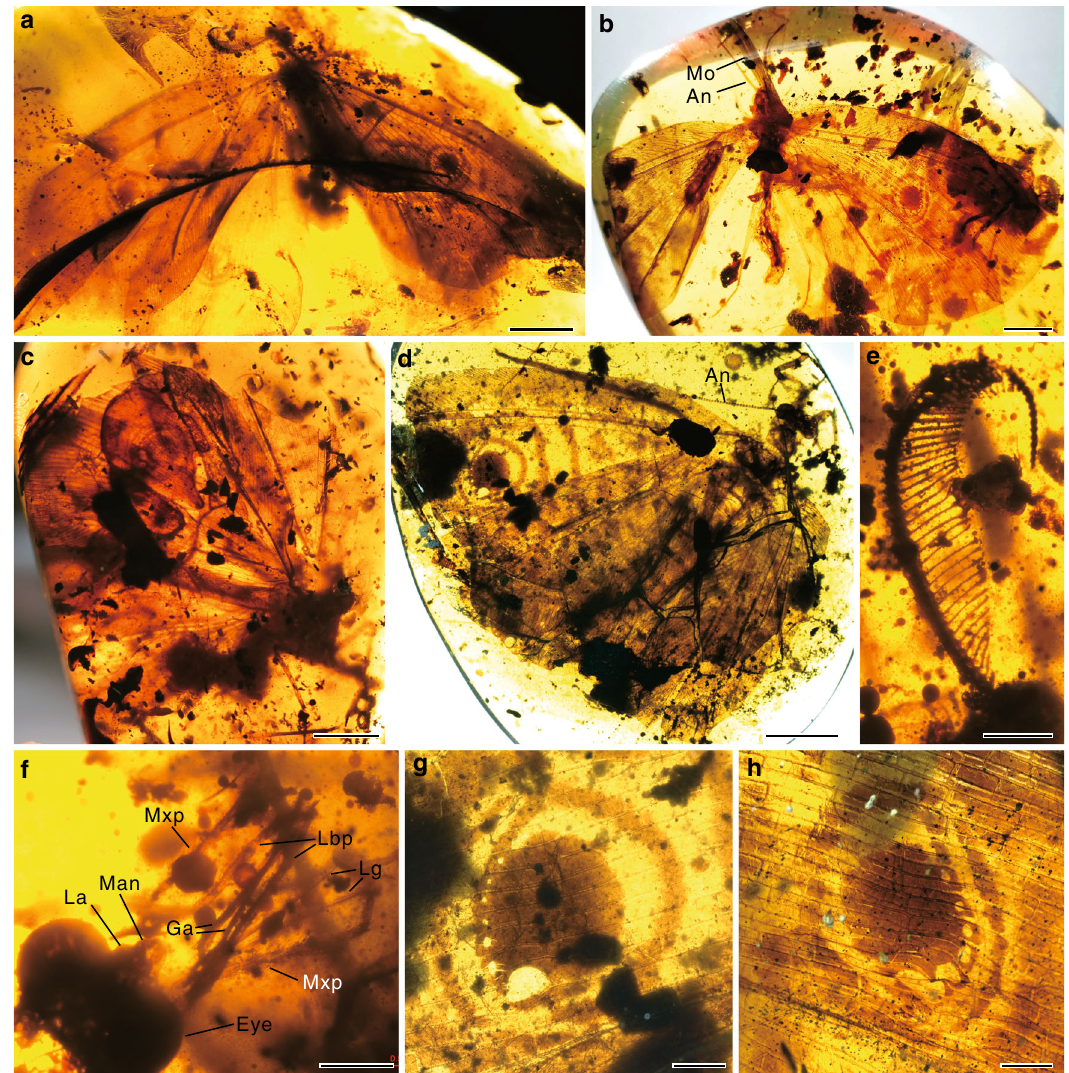
Fig. 1 Burmogramma liui from late Cretaceous Burmese amber. a , e , f Holotype NIGP164471, male, habitus ( a ), antenna ( e ) and mouthparts ( f ). b , g Paratype NIGP164472, female, habitus ( b ) and wing eyespot ( g ). c Paratype NIGP164473, female. d , h Paratype NIGP164475, female, habitus ( d ) and wing eyespot ( h ). An antennae, Eye compound eye, Ga galea, La labrum, Lbp labial palp, Lg ligula, Man mandible, Mo mouthparts, Mxp maxillary palp. Scale bars, 5 mm ( a – d ), 1 mm ( e – h